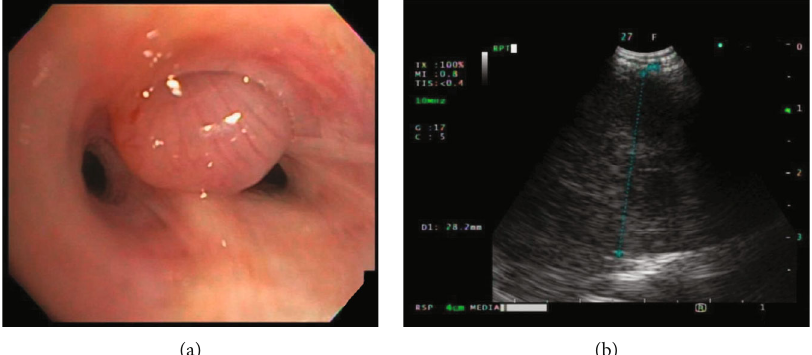
Figure 2: (a) Endobronchial smooth polypoid lesion arising from the right upper lobe apical segment. (b) Endobronchial ultrasound image of the right paratracheal heterogeneous mass.